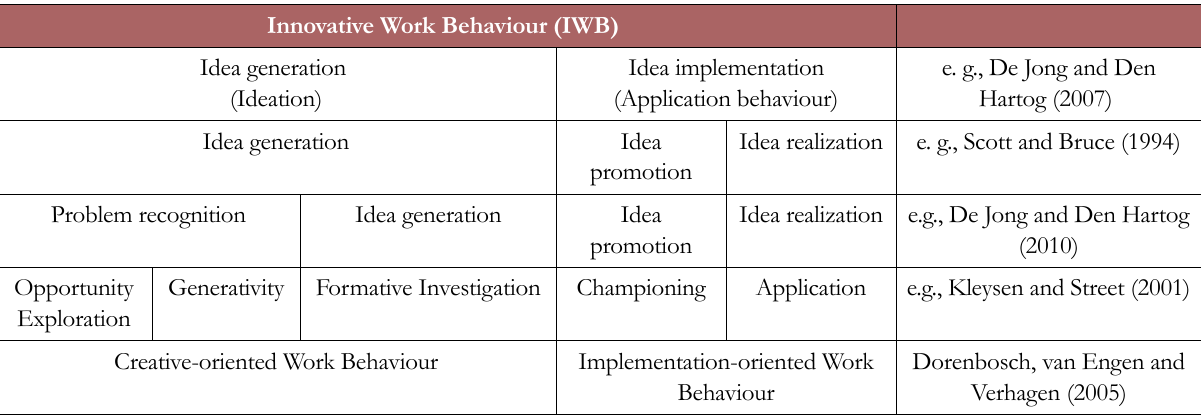
Table 1. Models of Innovative Work